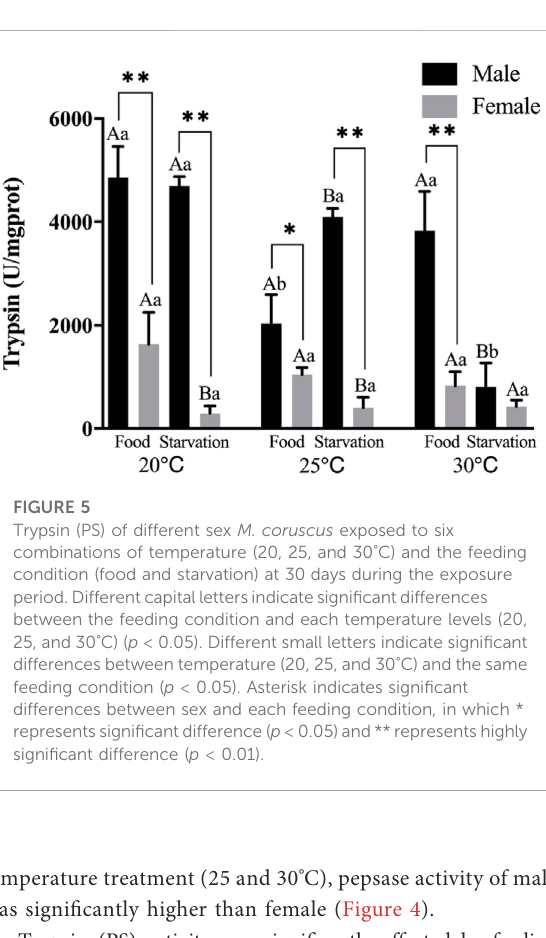
(Figure 3). For the effect of food condition, starvation signi fi cantly reduced LZM at normal and high temperature (25 ° C) in male, but the results of 30 ° C were opposite. Also, starvation had no signi fi cant impact on LZM at high temperature in female treatment (Figure 3). Sex differences were signi fi cantly noted by feeding condition; in 20 ° C-Food treatment and high temperature (30 ° C) treatment, LZM of male was signi fi cantly higher than female (Figure 3).